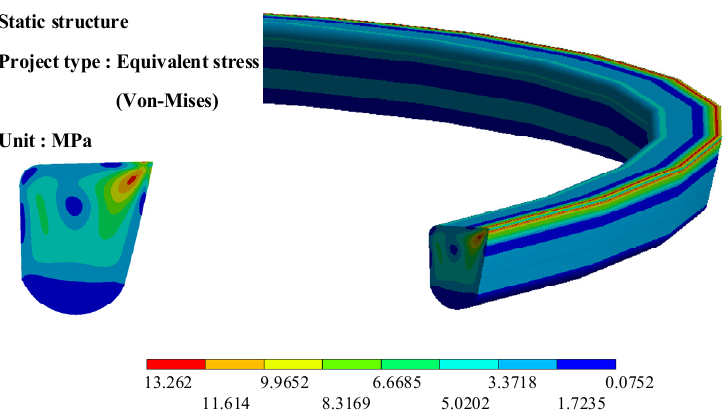
Figure 9. Contact pressure distribution of O-ring under no pressure.